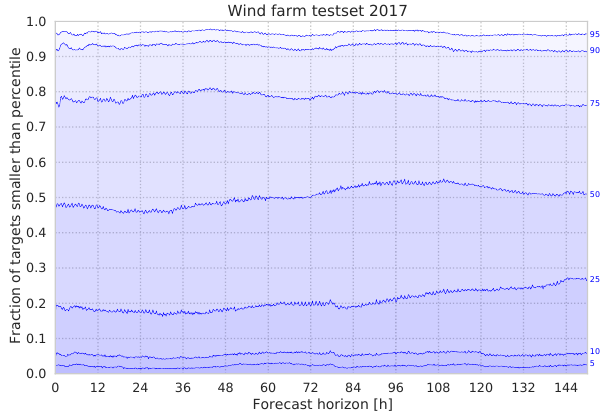
Figure 4. To validate the resulting error distributions over the fore- cast horizon, the fraction of observed test set target values below certain percentiles (blue labels on the right) are plotted. For exam- ple, at 48h lead time, only about 5% of the test data fall below the 10-percentile, which means that small power output values are generally underrepresented in the class